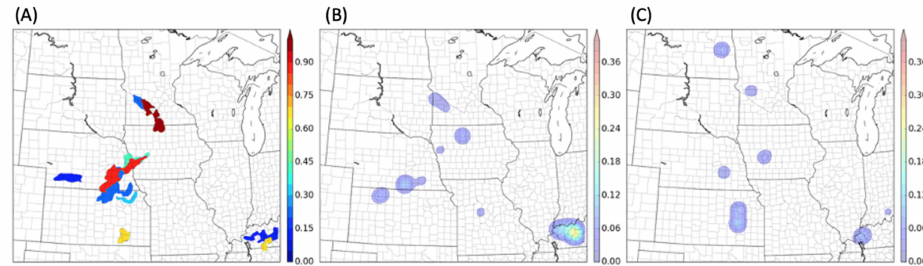
Figure 4. Plotting examples of ( A ) meso-alpha (mesoscale organized) objects, ( B ) meso-beta (multi- cell) objects, and ( C ) meso-gamma (single-cell) objects. Meso-alpha objects use the OBPROB method, while meso-beta and meso-gamma use a Gaussian smoothed contour plot of object